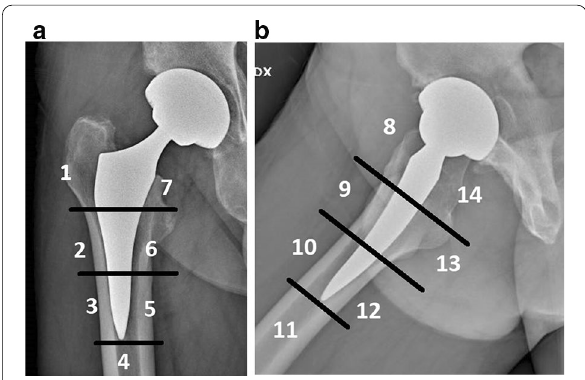
Fig. 1 Radiographic follow-up and definition of Gruen’s periprosthetic zones in anteroposterior view ( a ) and axial view ( b